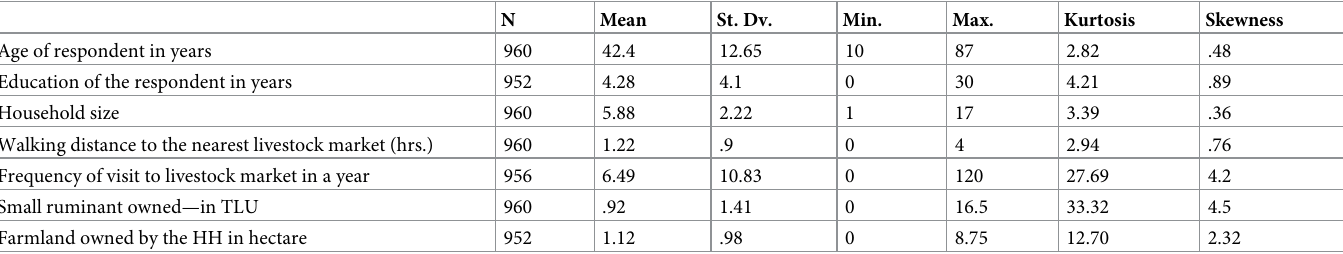
Table 2. Summary of the characteristics of the sample